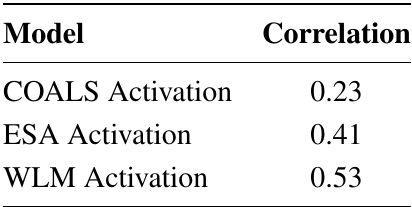
Table 17. Spearman rank correlations with backward associative strength for DRM lists, using an activation-type metric (N =